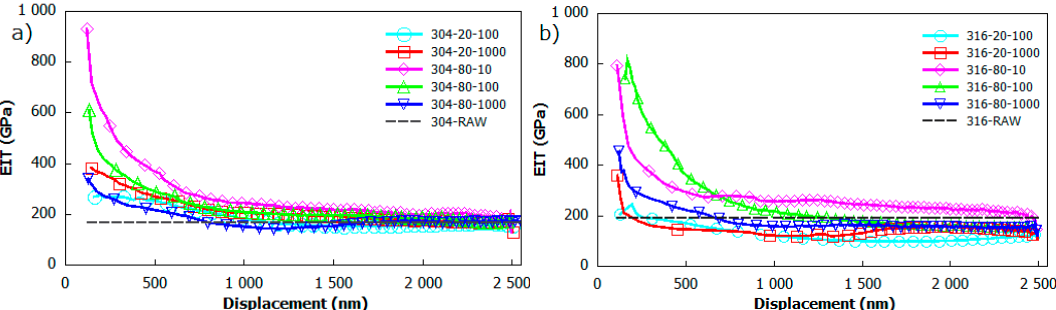
Figure 9. The dependence of elastics modulus (E IT ) corresponding to indentation depth of: ( a ) AISI 304; and ( b ) AISI 316 stainless steel. Table 4. The maximum nanoindentaion hardness H IT , maximum elastic modulus E IT and average H IT and E IT obtained for the indentation depth range of 1000–2500 nm.